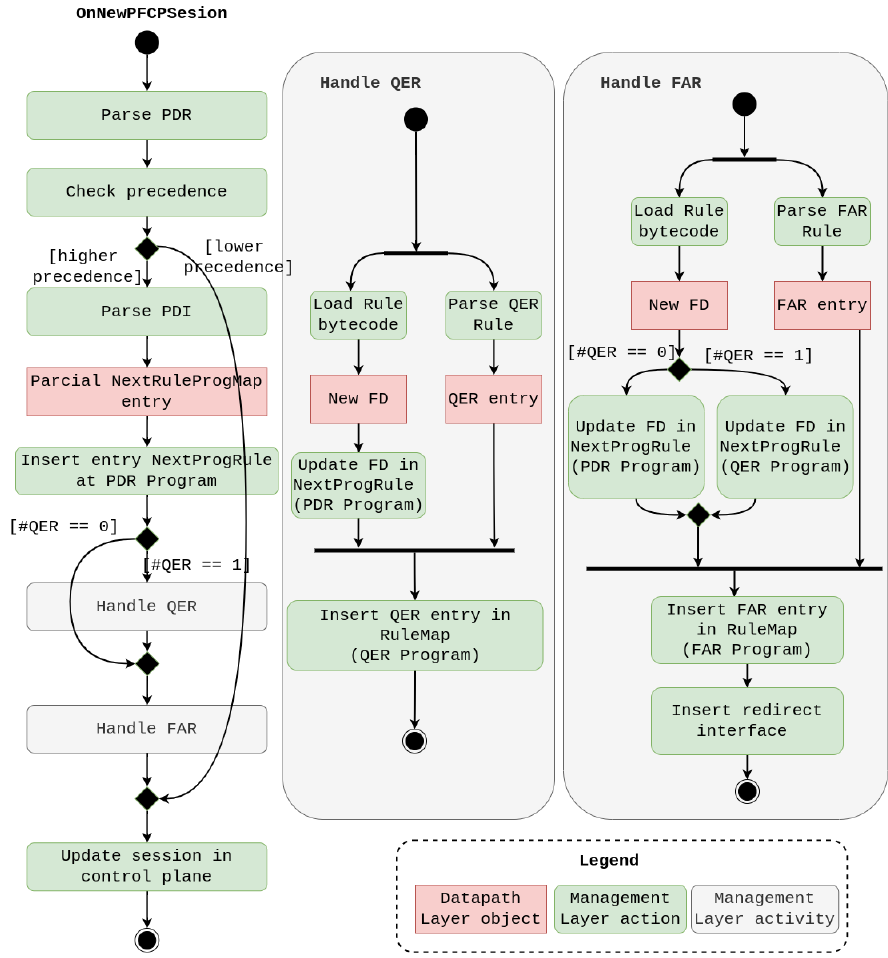
Figure 12. PFCP session creation activity diagram in Management Layer (version